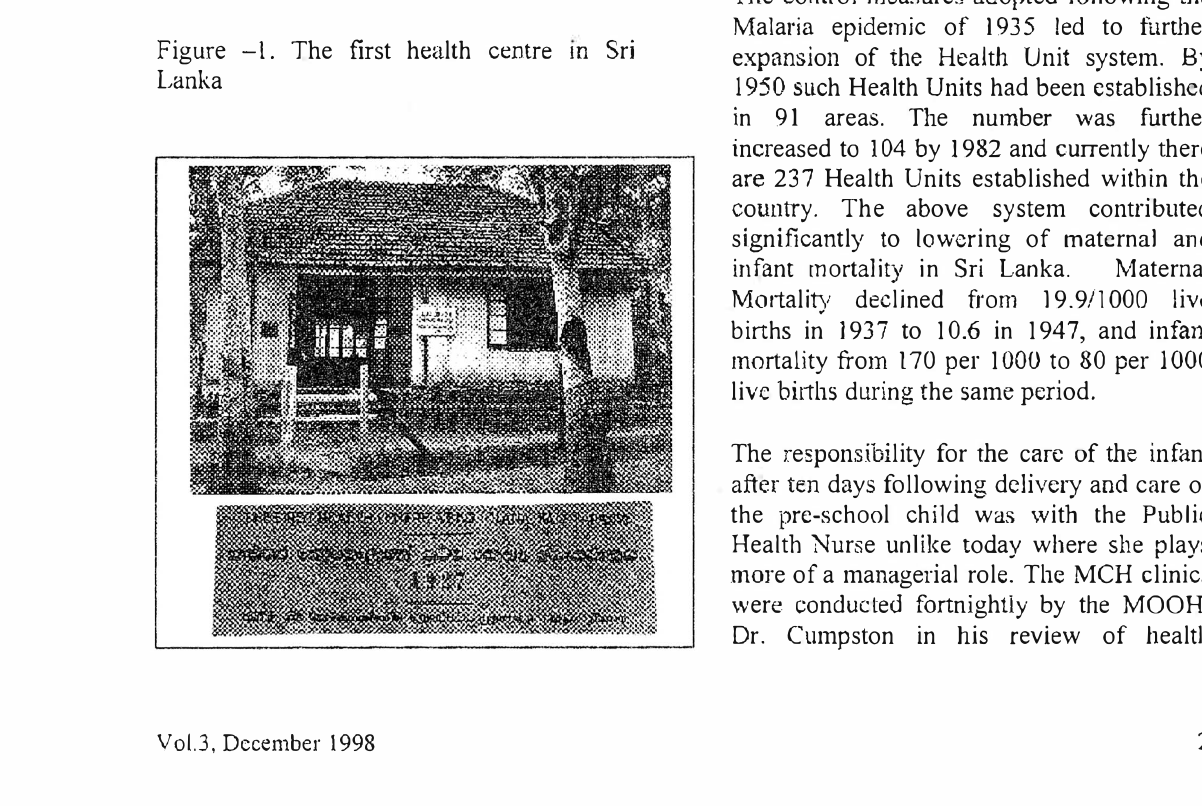
Figure -1. The first health centre m Sri